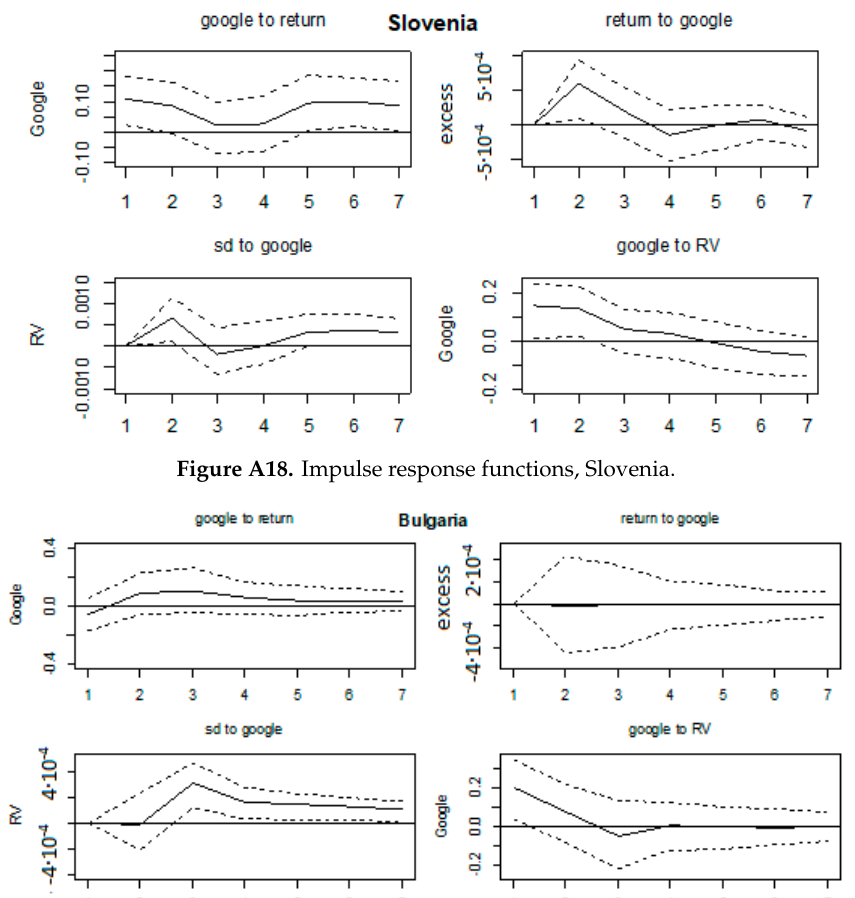
Figure A19. Impulse response functions, Bulgaria.